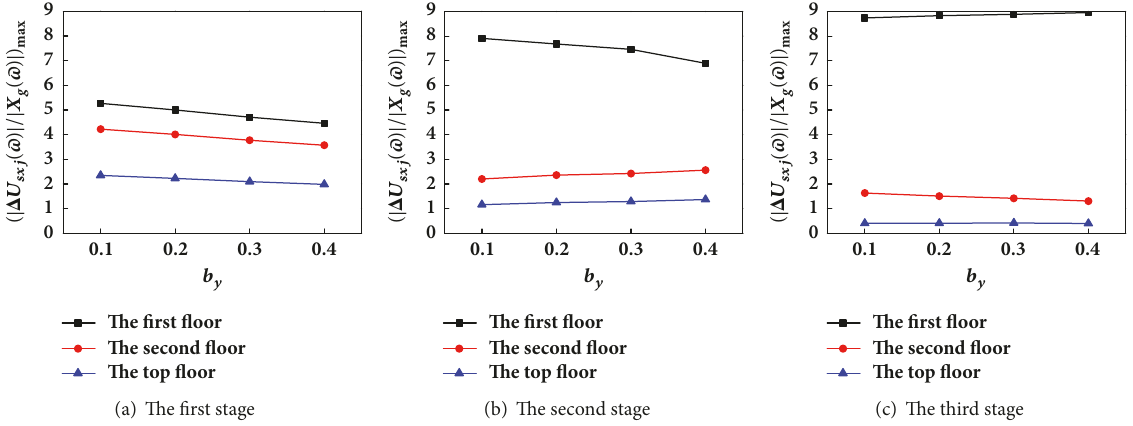
Figure 12: Interstory translation displacement in the 𝑥 direction under different 𝑏 𝑦 values.